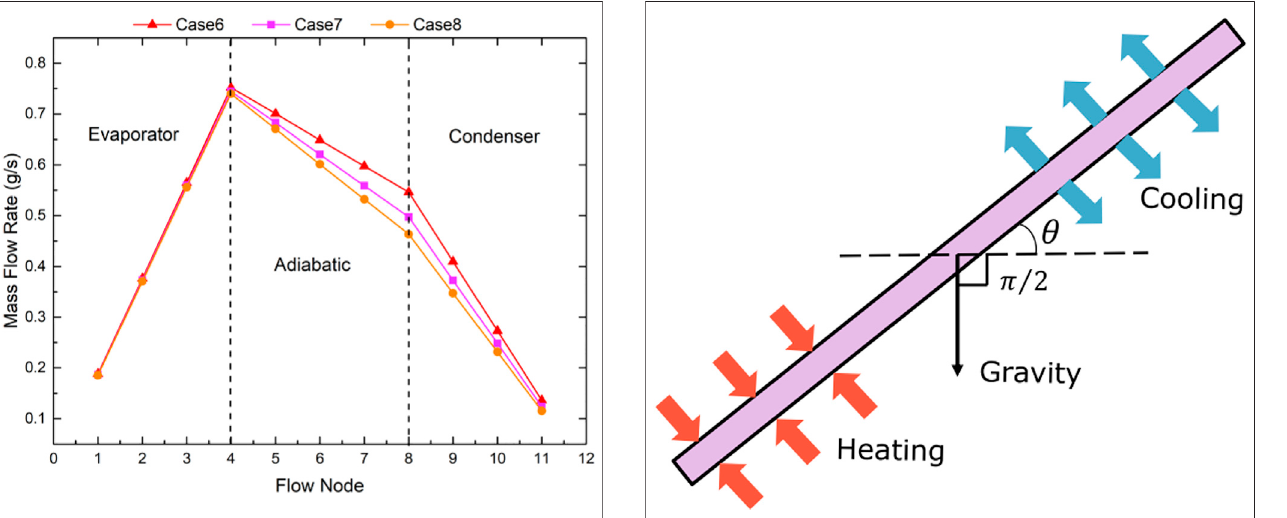
TABLE 4 | Pressure drop and heat transfer of a heat pipe at different inclined angles. angle ( + ) Walltemperature